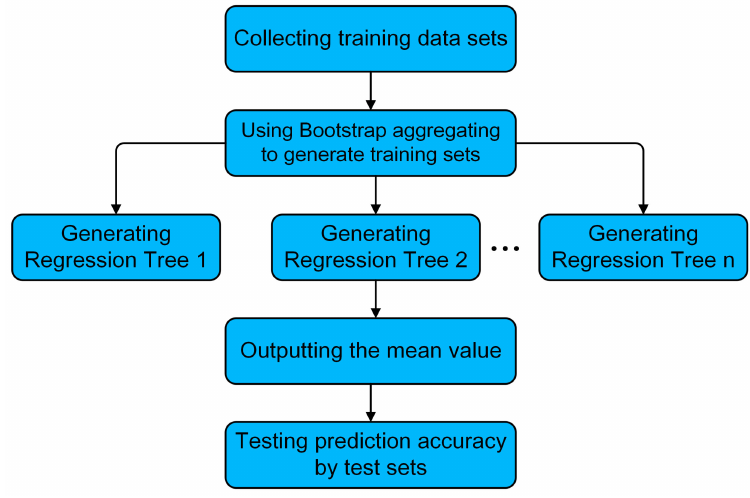
Figure 4. The flowchart of the random forest algorithm.